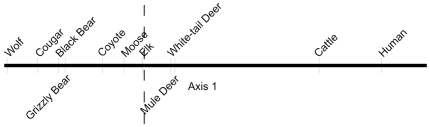
Co-occurrence of species at camera sites as determined by non-metric multidimensional scaling (NMS) ordination of species counts at camera sites in southwest Alberta, Canada during the summer of 2008.Ordinations along axis one are indicated. Location along axis one where the NMS score equals zero is indicated by a vertical dashed line.